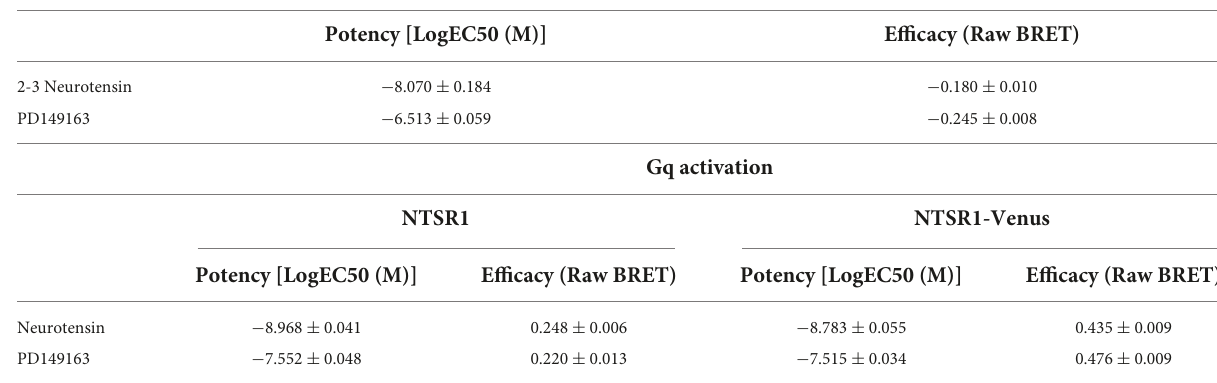
TABLE 1 Efficacies and potencies of NTSR1 agonists on receptor internalization and Gq